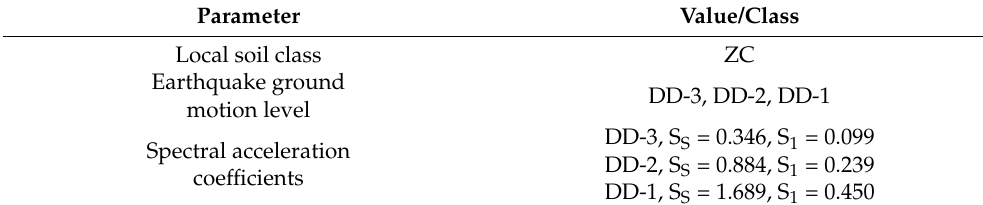
Table 2. The seismic and soil parameters.